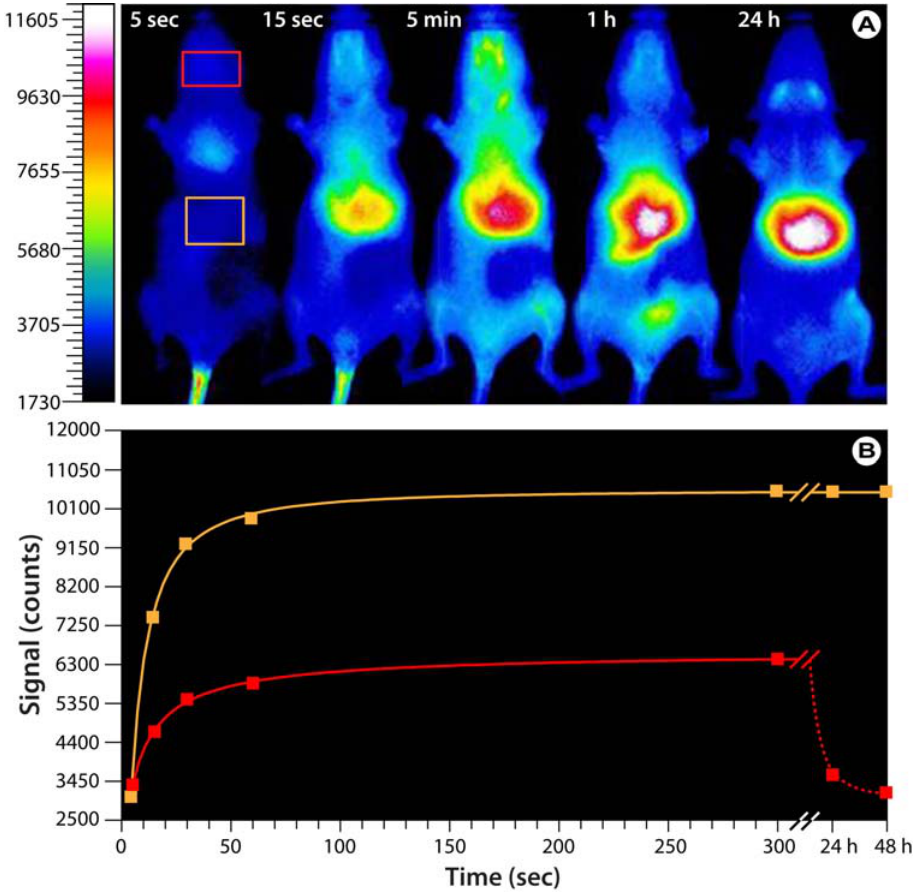
Figure 6. Bio-imaging with hyaluronan analogs modified with the near-infrared IR-783 dye. ( A ) Optical images of SKH mice injected with fluorescent HA-NIRdye (1% dye load). Based on Reference [76]. Note that the probe predominantly accumulates in the upper abdominal and thoracic organs, i.e. , liver, heart, lungs, kidneys, stomach, and lymph nodes. After 24 − 48 h, the probe is exclusively found in the liver. ( B ) Progression of the fluorescence intensity in the boxes indicated in